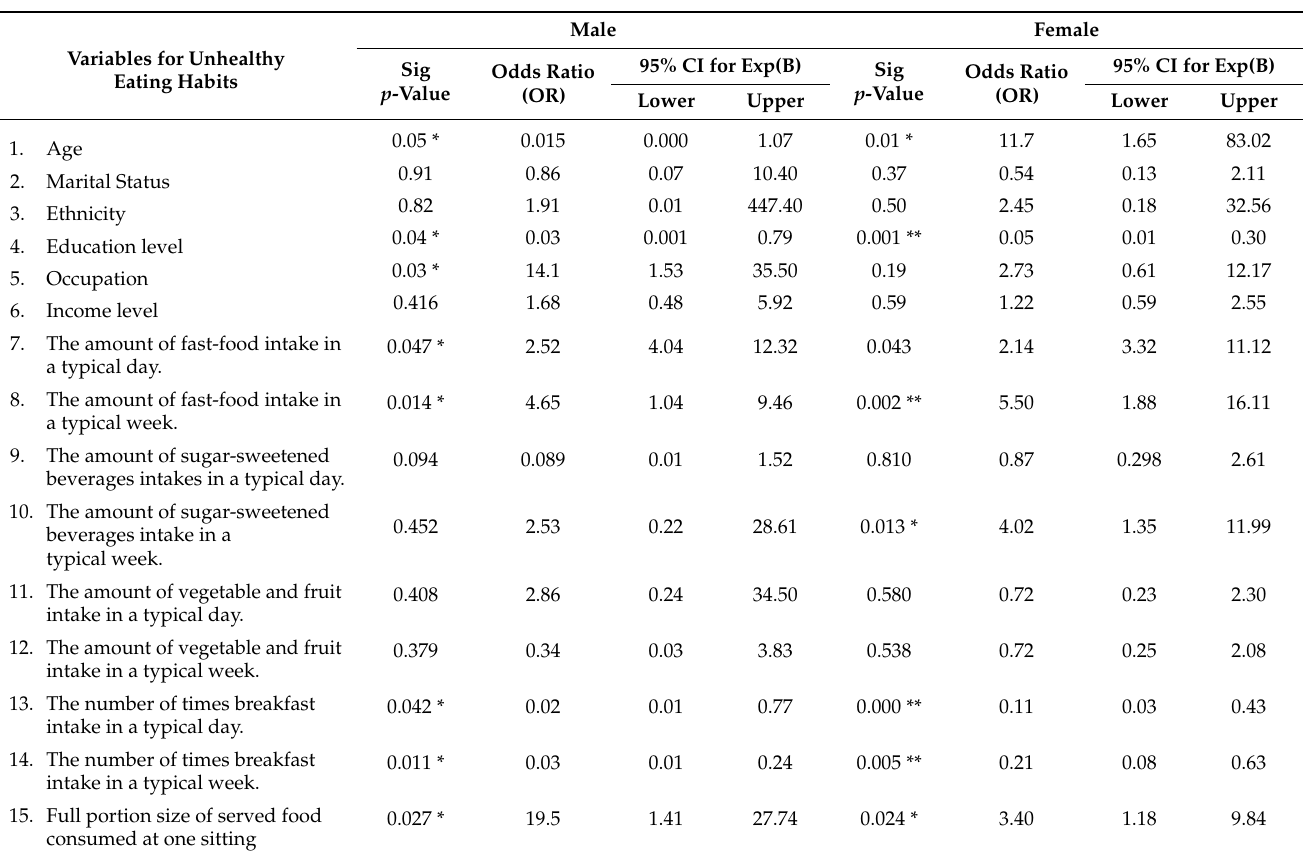
Table 5. Association between unhealthy eating habits and BMI using binary logistic regression across gender-related variances when sociodemographic and SES factors were adjusted 1